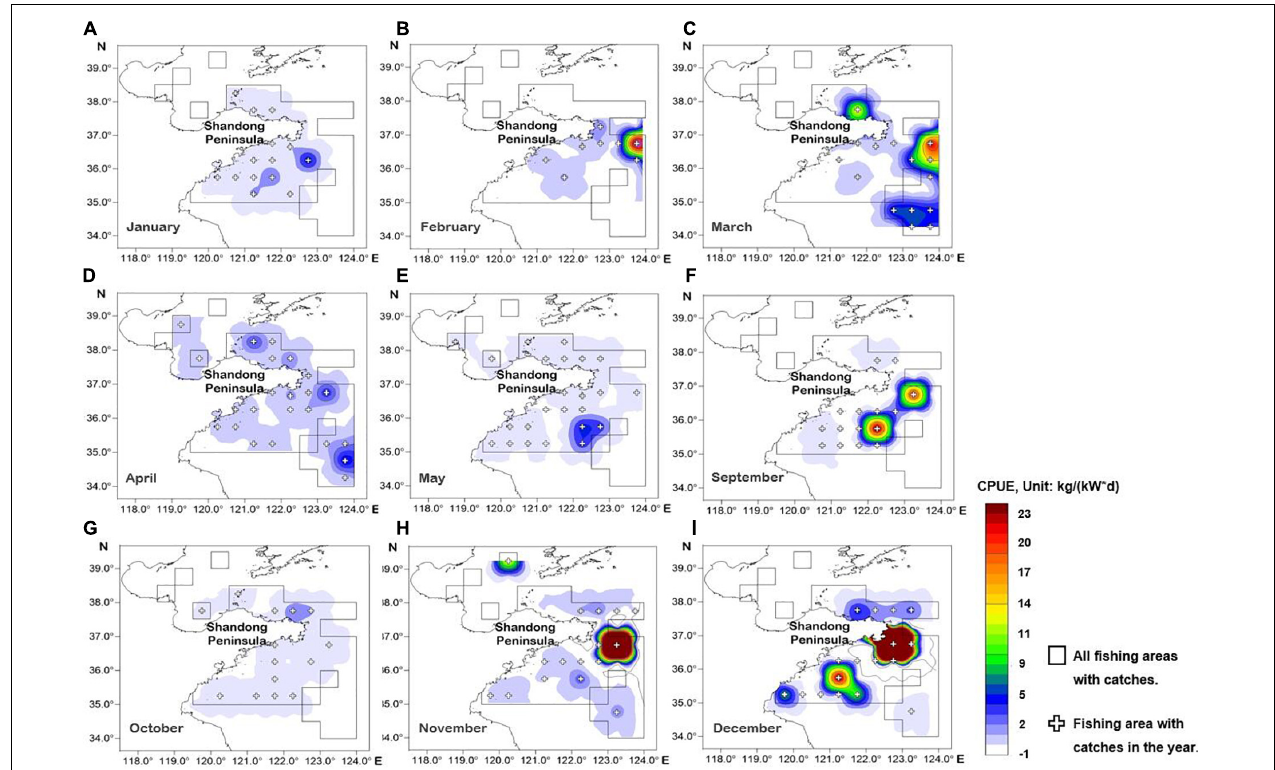
FIGURE 3 | Spatial distribution map of Lophius litulon abundance by fishing area and month (except from June to August due to fishing closure). (A) January; (B) February; (C) March; (D) April; (E) May; (F) September; (G) October; (H) November; (I) December.